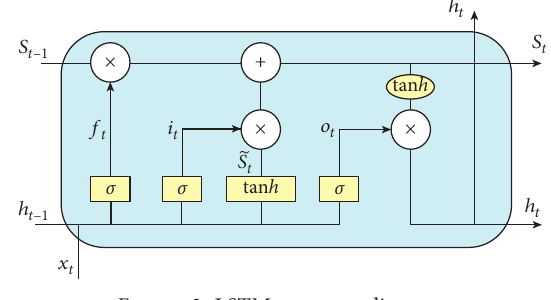
Figure 2: LSTM structure